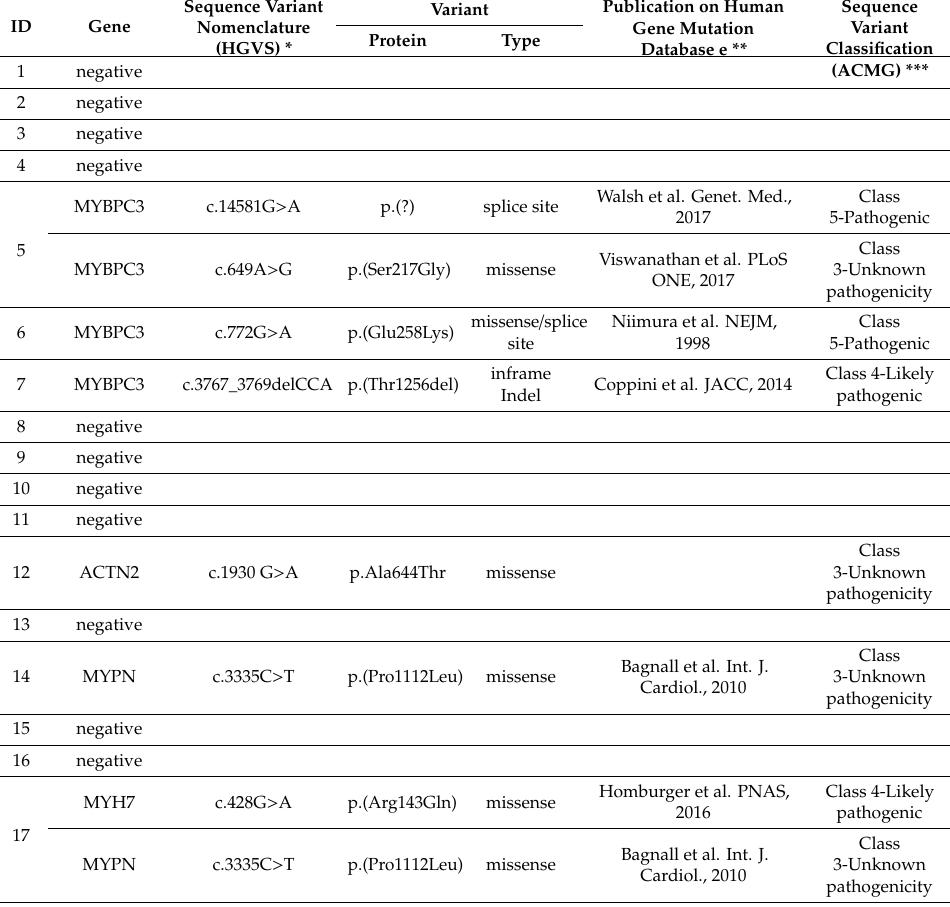
Table 3. Gene variants identified in HCM